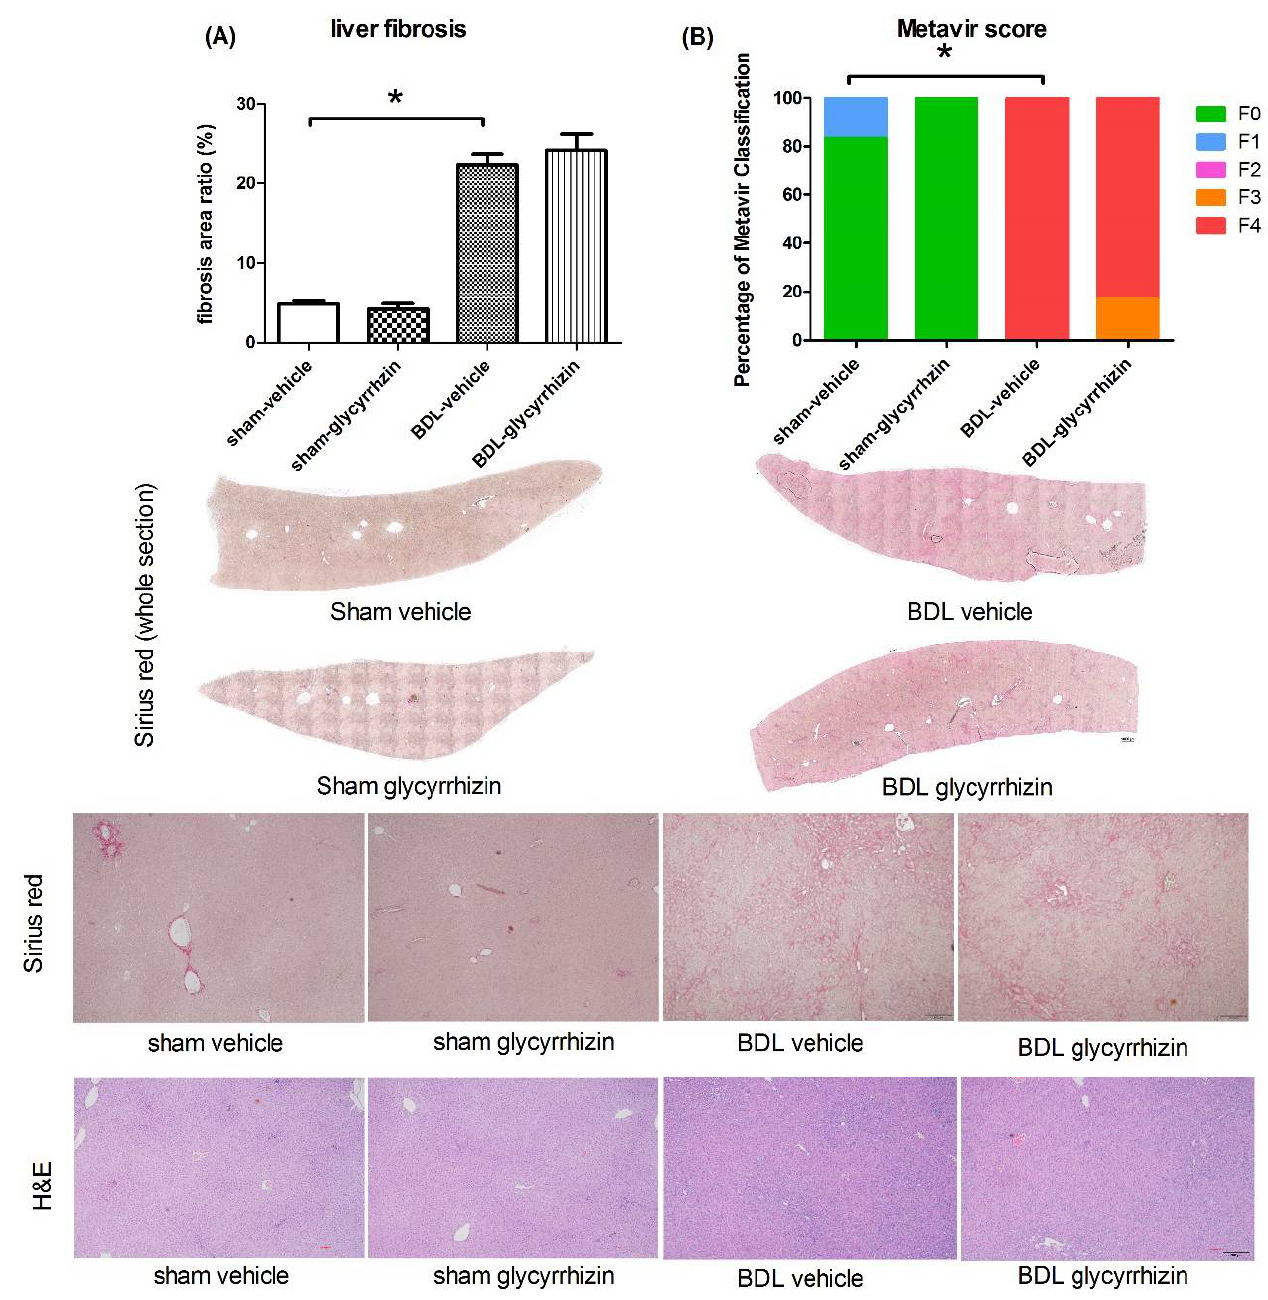
Figure 6. Effects of glycyrrhizin on liver fibrosis. ( A ) The severity of liver fibrosis was evaluated by fibrosis area ratio. The area ratio was significantly increased in BDL-vehicle group compared with sham-vehicle group. Glycyrrhizin treatment tended to attenuate the fibrosis severity ( n = 6, 6, 6, 6). ( B ) The severity of liver fibrosis was further classified blindly by Metavir scoring system by an independent investigator. The results were compatible with the findings of the area ratio analyses that BDL significantly increased the fibrosis severity. Glycyrrhizin did not affect liver fibrosis in sham or BDL groups ( n = 6, 6, 6, 6). Scale bar of upper panel = 1000 μm, scale bar of lower panel = 200 μm. * p < 0.05